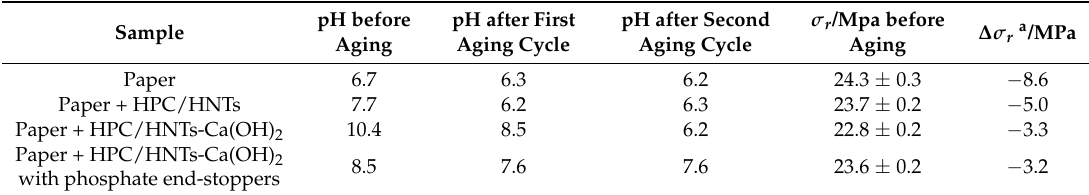
Figure 8. Stored energy up to sample breaking from tensile stress measurements. The error is based on the standard deviation from repeated experiments. Table 1. Paper pH values and stress at the breaking point before and after aging under HNO 3 saturated vapours.